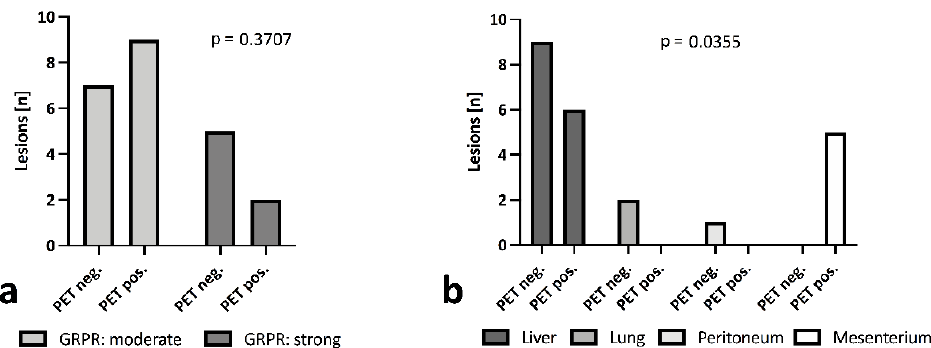
Figure 4. 68 Ga-NeoBOMB1 uptake in lesions grouped by moderate or strong GRPR expression ( a ) and grouped by tumor site ( b ), calculated via Fisher’s exact test and χ 2 test. All lung lesions appeared calcified, suggesting no vitality.